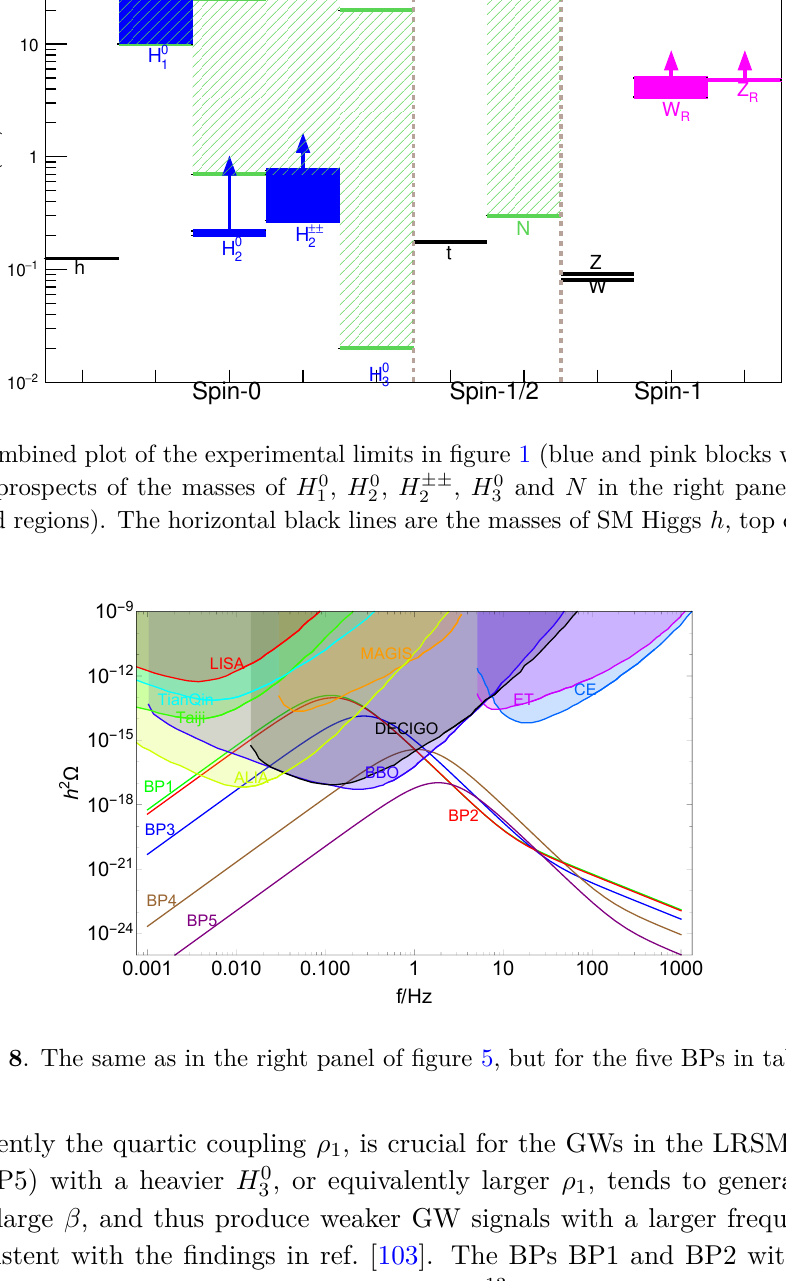
Figure 8 . The same as in the right panel of figure 5, but for the five BPs in table